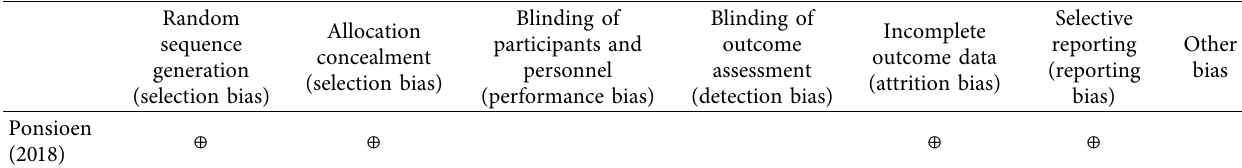
Table 6: Risk of bias of randomized controlled trial using the Cochrane Risk of Bias 2 tool.